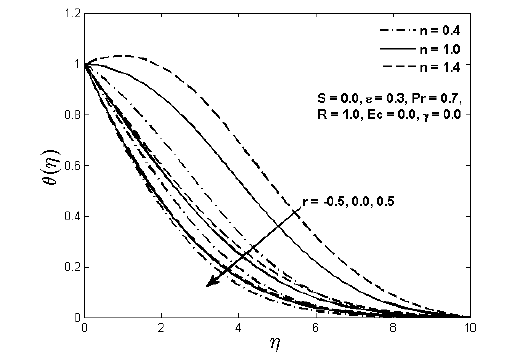
Figure 8. Temperature profiles for various values of r and n when (cid:101) >